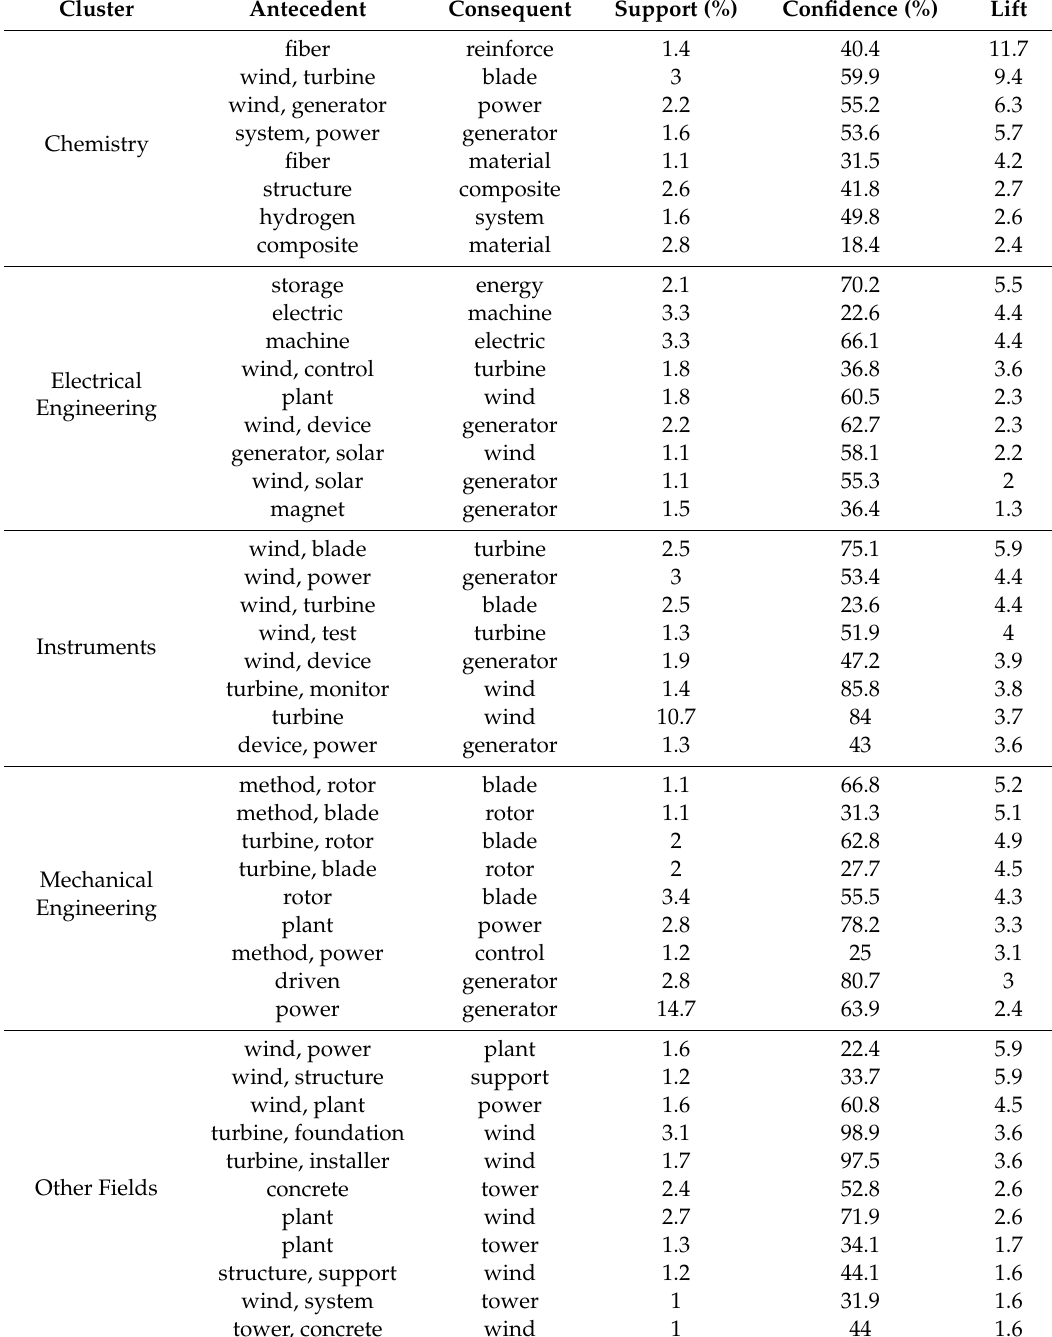
Table 8. Examples of association rules between the key terms and their support, confidence, and lift.